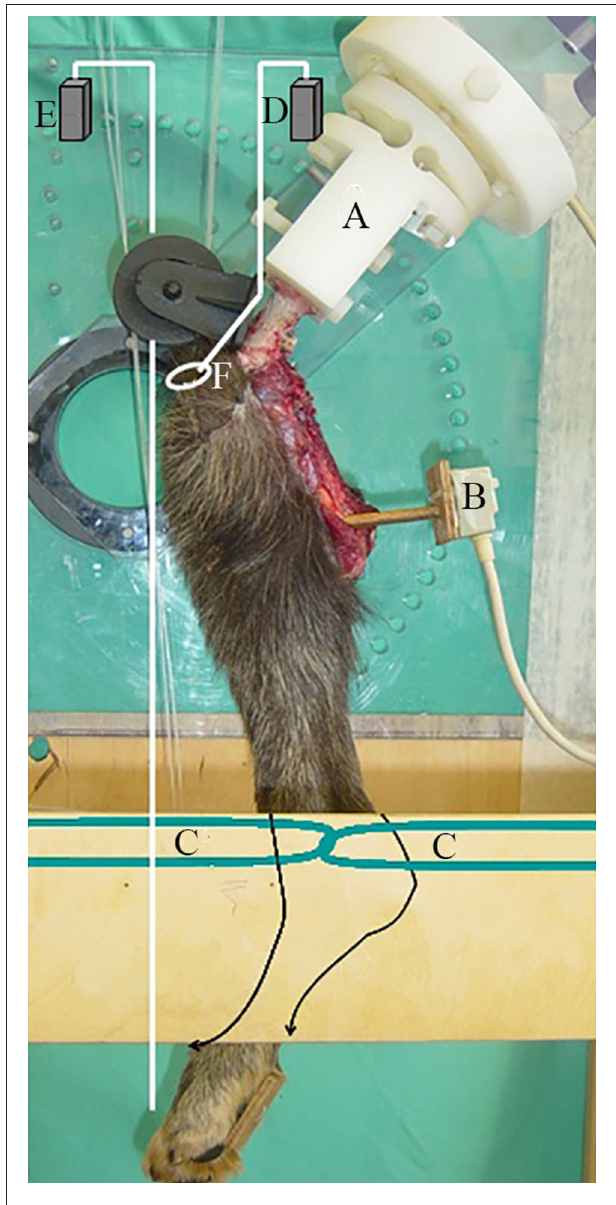
FIGURE 1 | Schematic representation of the loads applied to the patella and pes via a system of weights and pulleys within the joint testing machine. The position of the sensor and the restraint of the distal tibia are also illustrated. (A) Bone clamp, (B) Sensor, (C) Restraint of distal tibia, (D) Quadriceps load, (E) Pes load, (e)